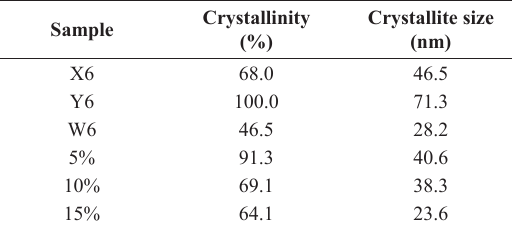
/ZSM-12 samples: (a) 5% of Ti, (b) 10% of Ti and (c) 15% of 2 Table 2. Crystallinity and crystallite size of calcined ZSM-12 zeolites and for the TiO /ZSM-12 catalysts impregnated with 5, 2 10 and 15% of Ti over the sample Y6.